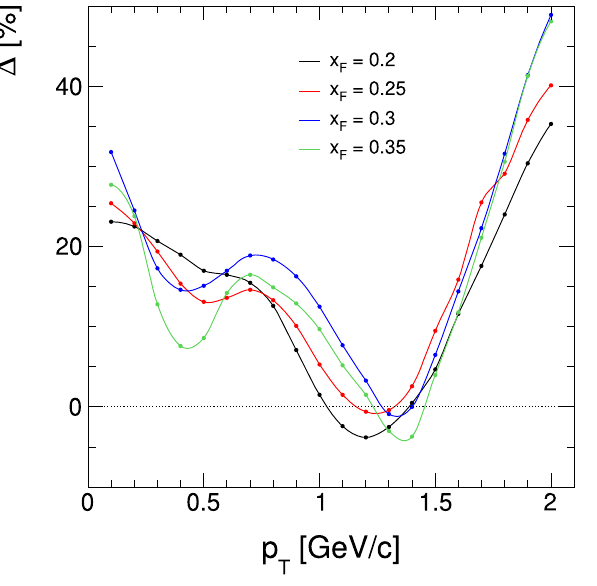
Fig. 190 Percent difference Δ between data and resonance prediction as a function of x F for p T = 0.1, 0.5, 0.7, 0.9 and 1.1 GeV/c